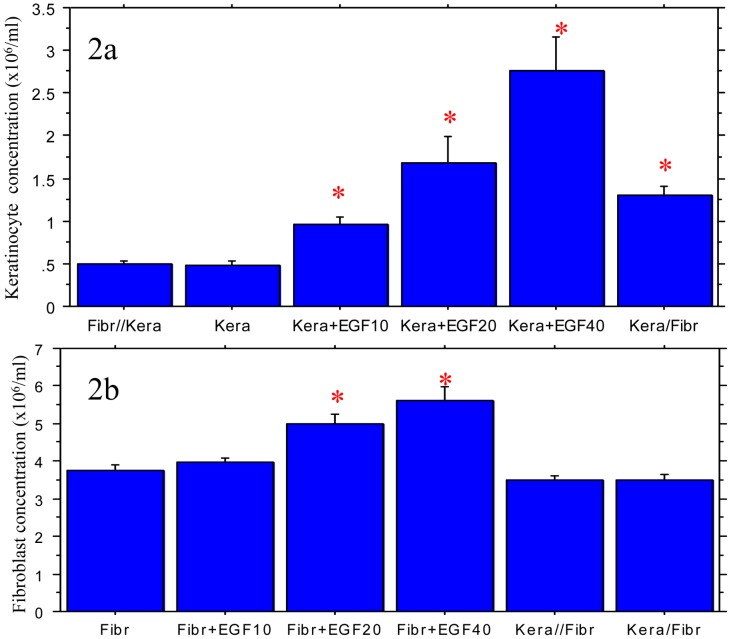
Effects of different cultures on the growth of keratinocytes (2A) and fibroblasts(2B). 2A: Keratinocytes were cultured with fibroblasts in common 6-well plates (Kera/Fibr), with Fibr in transwell toseparate keratinocytes and fibroblasts (Kera//Fibr), with different concentrations of EGF (EGF10: EGF 10 ng/ml, EGF20: EGF 20 ng/ml and EGF40: EGF 40 ng/ml) or keratinocytes alone (Kera). Compared to Kera or Fibr//Kera, *P<0.01. Four cultures in each condition. 2B: Fibroblasts were cultured with keratinocytes in common 6-well plates (Kera/Fibr), with keratinocytes in transwell to separate keratinocytes and fibroblasts (Kera//Fibr), with different concentrations of EGF (EGF10: EGF 10 ng/ml, EGF20: EGF 20 ng/ml and EGF40: EGF 40 ng/ml) or fibroblasts alone (Fibr). Compared to the groups without star, *P<0.01. Four cultures in each condition.